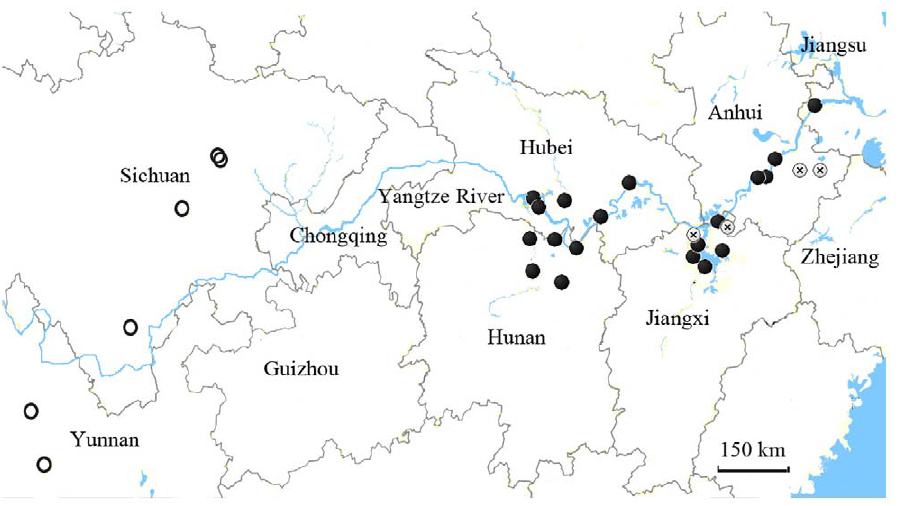
N , smooth-shelled with varix as